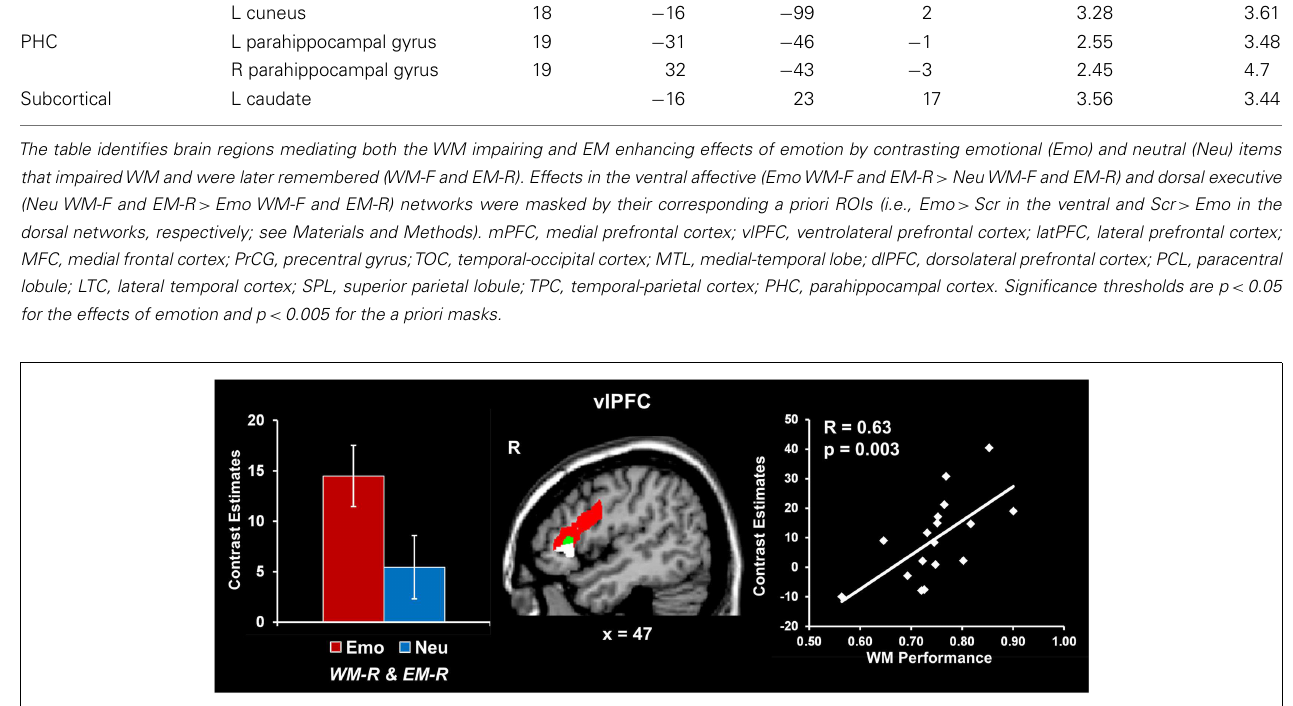
FIGURE 3 | Increased right vlPFC activity linked to coping with emotional distraction and enhanced EM . Right vlPFC showed increased activity to emotional distracters associated withWM success and later remembered relative to both neutral distracters associated withWM success (red blob) and emotional distracters associated withWM impairment (green blob). A positive correlation was also identified between activity in this right vlPFC area andWM performance for emotional distraction (white blob; see Results). In contrast, the left inferior frontal cortex showed increased activity to emotional distracters associated with WM success relative to emotional distracters associated withWM impairment, independent of whether they were later remembered or not (Talairach coordinates: x =− 46, y = 8, z = 22; not shown).This suggests a hemispheric dissociation between brain activity involved in coping with